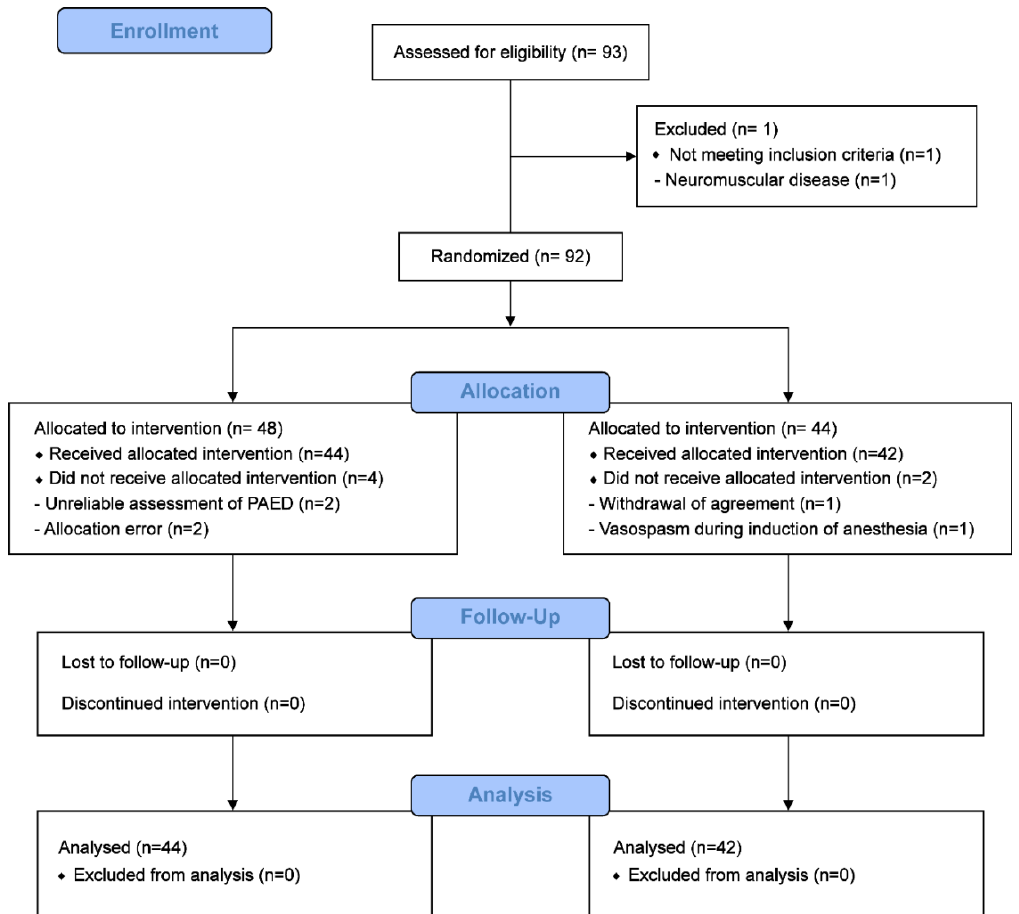
Figure 1. Consolidated Standards of Reporting Trials (CONSORT) diagram.